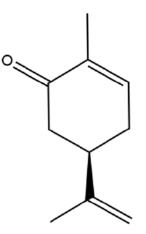
Figure 1. Structural formula of (R)-(-)-carvone.